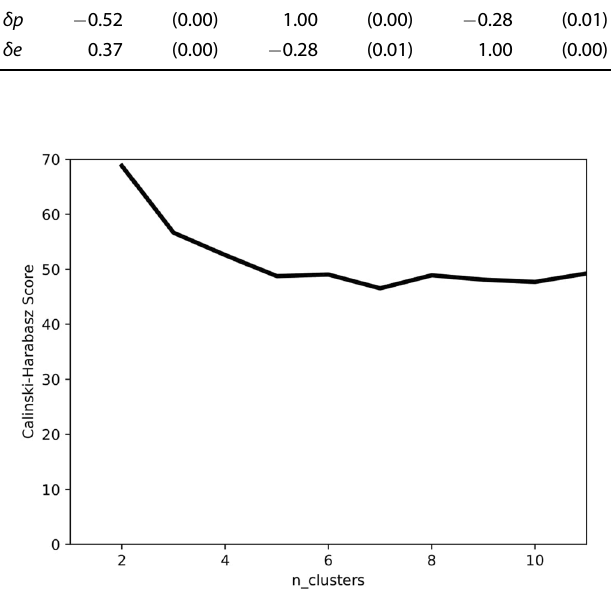
Fig. 2 Calinski-Harabasz score graph as a function of the number of clusters. From the in fl ection in the curve, four clusters are chosen.